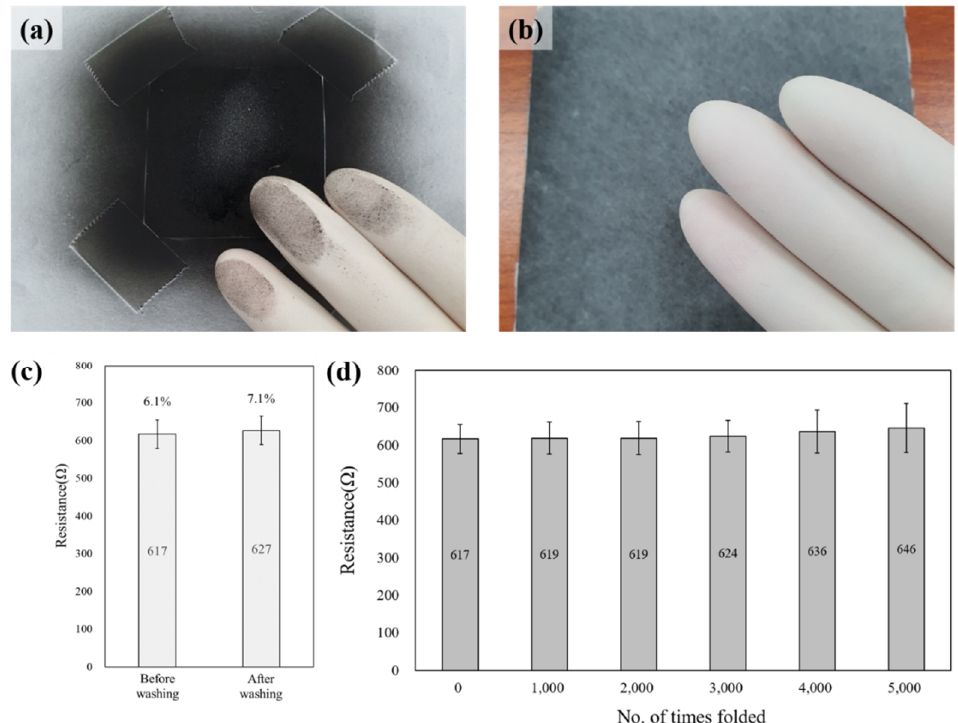
Figure 5. Surface durability ( a ) before and ( b ) after electrospinning of the conductive nonwoven MWCNT composite. Resistance value of the MWCNT composite conductive nonwoven ( c ) before and after washing and ( d ) with respect to the number of times folded (every 1000).